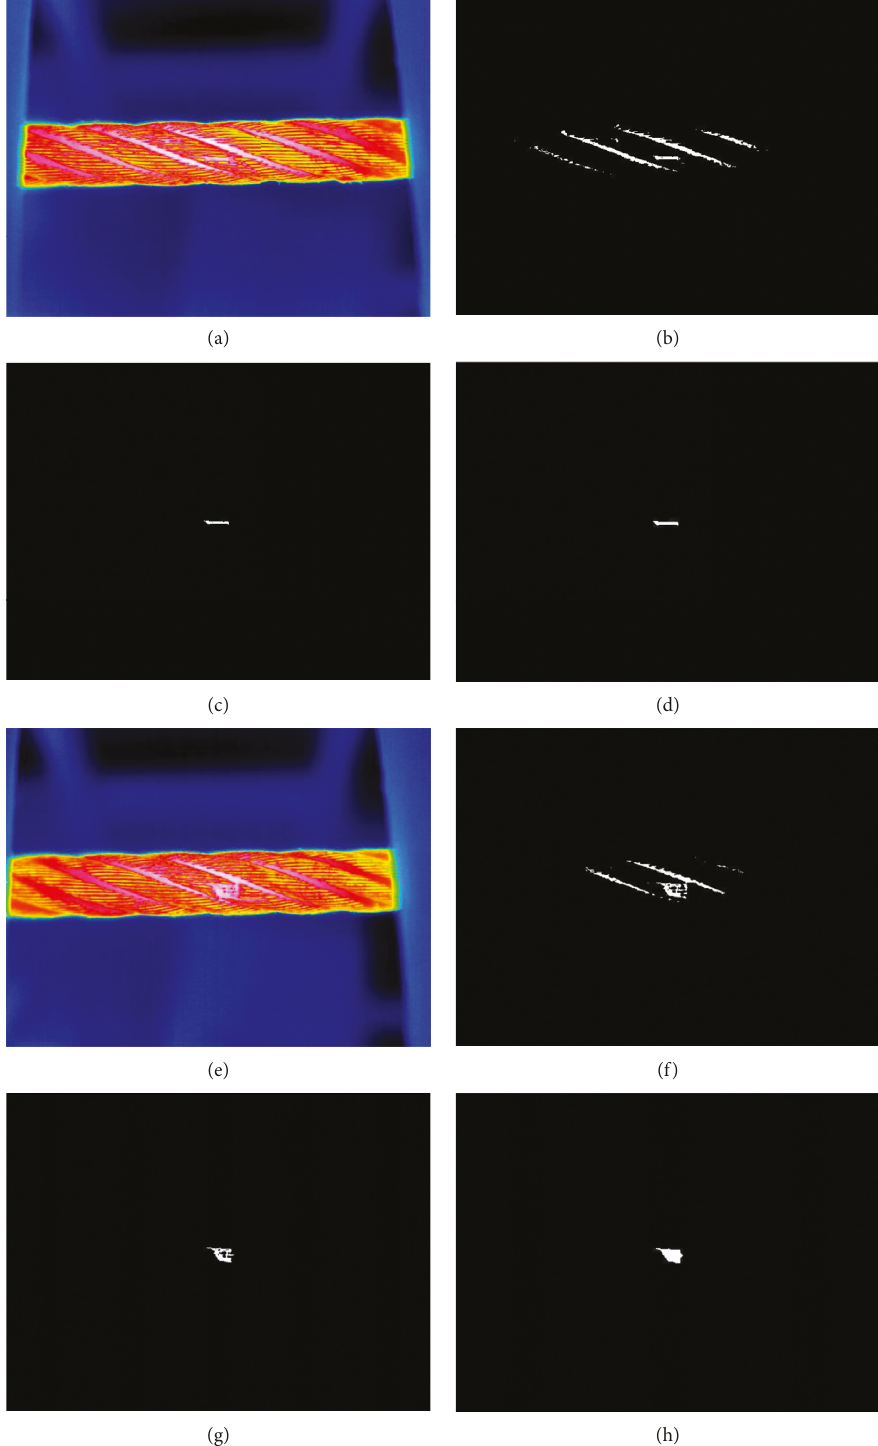
Figure 11: Infrared image processing: (a, e) Original infrared image; (b, f) ROI area binary map; (c, g) extracted defect portion; (d, h) morphology of defect part after